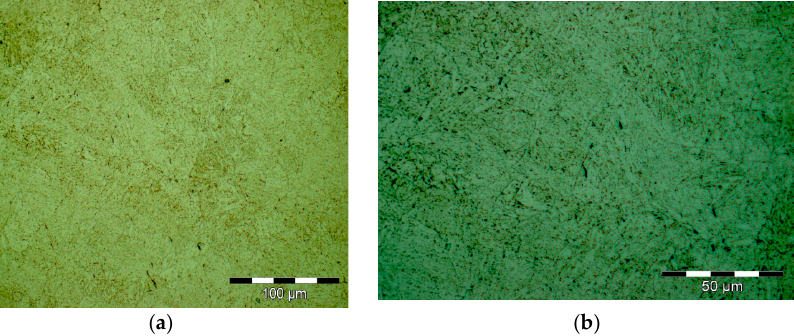
Figure 4. Optical microscopy images from secondary heat treatment; 500× magnification ( a ) 1000× ( b ).